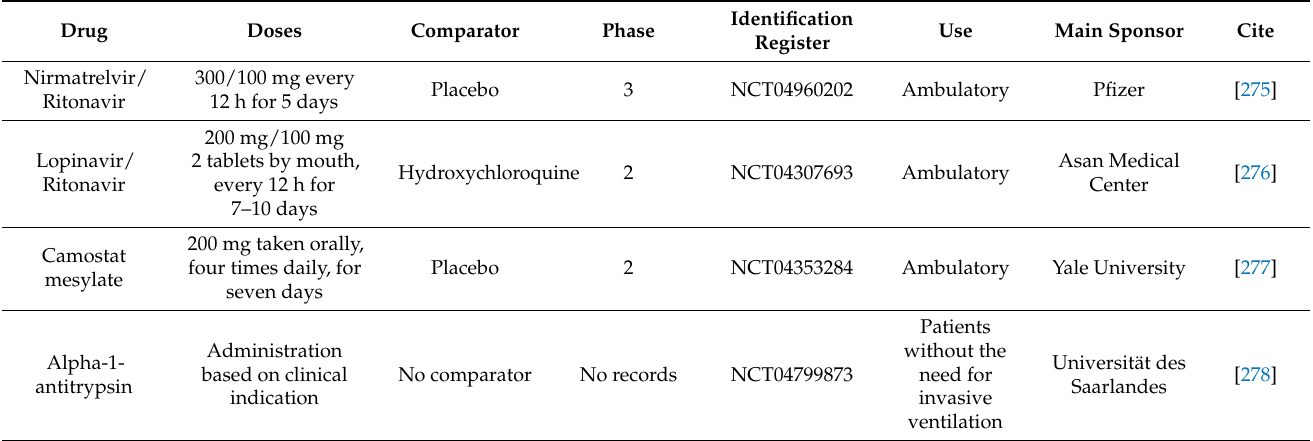
Table 4. Protease inhibitors in clinical